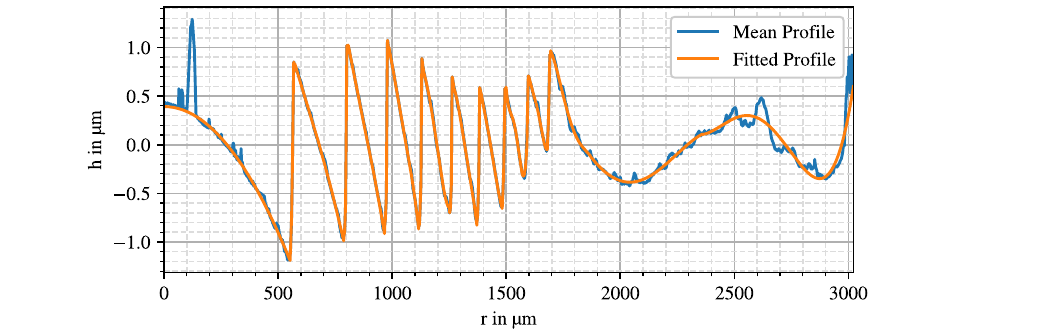
Figure 3. MS612 anterior diffraction profile.